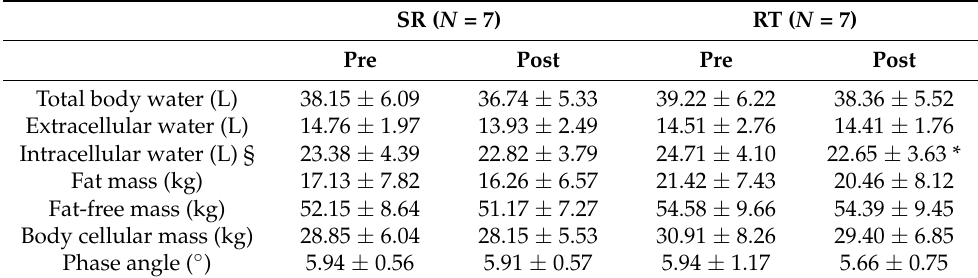
Table 5. Bioimpedance analysis (BIA) results of spot reduction (SR) and resistance training (RT)